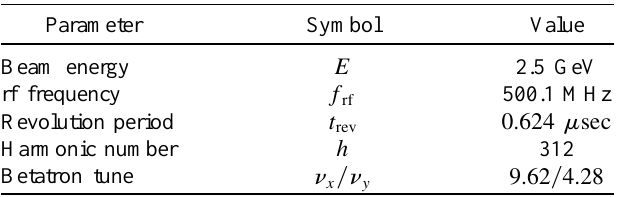
TABLE I. Main parameters of the PF